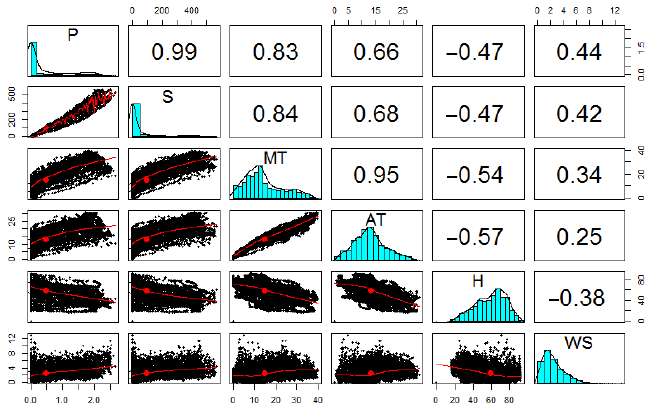
Figure 2. Correlation analysis of PIoT data in the PV system: P (Power), S (Solar Radiation), MT (Module Temperature), AT (Ambient Temperature), H (Humidity), and WS (Wind Speed).